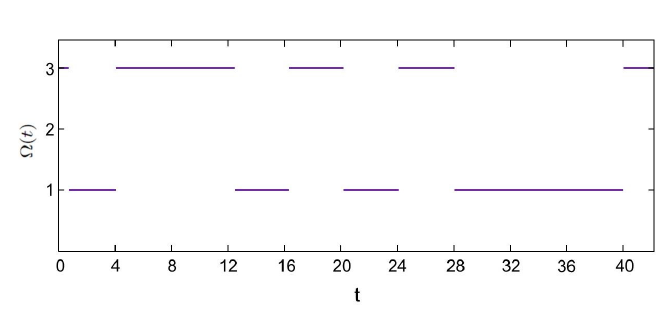
Figure 1. The graph of discontinuous unpredictable function Ω ( t )